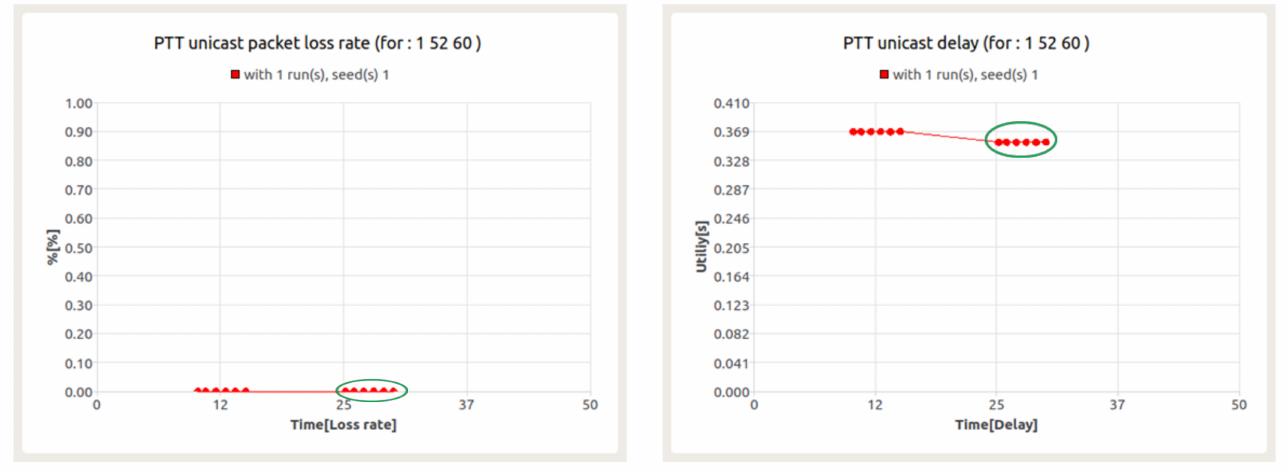
Figure 17. Packet loss ratio ( left ) and e2e delay ( right ) for PTT session—node 60.